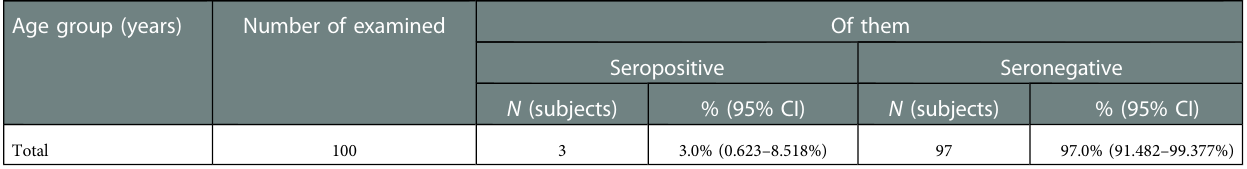
TABLE 7 IgA blood serum levels to pertussis in healthcare professionals. Age group (years)